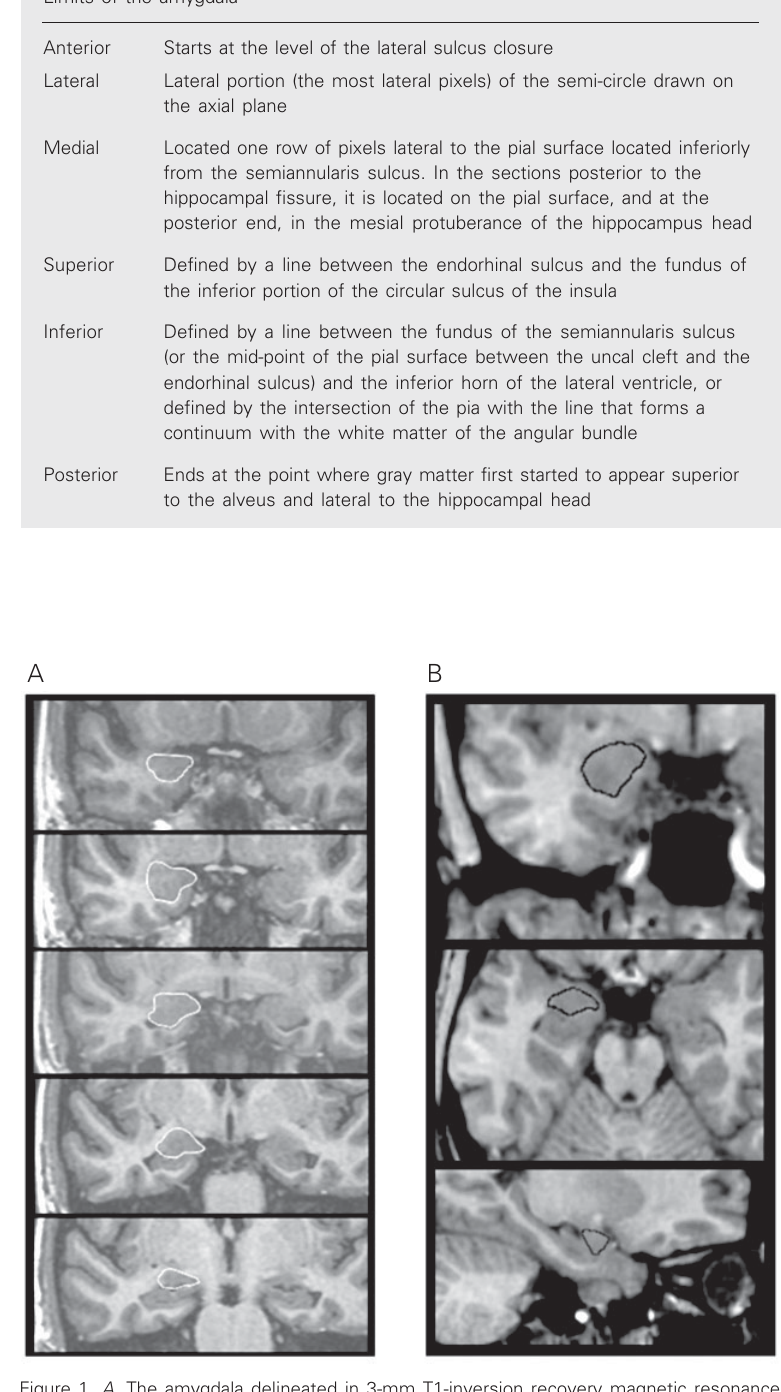
Figure 1. A , The amygdala delineated in 3-mm T1-inversion recovery magnetic resonance imaging (MRI) in its rostrocaudal extension. B , The amygdala delineated in 1-mm T1 MRI on the coronal, axial and sagittal planes,